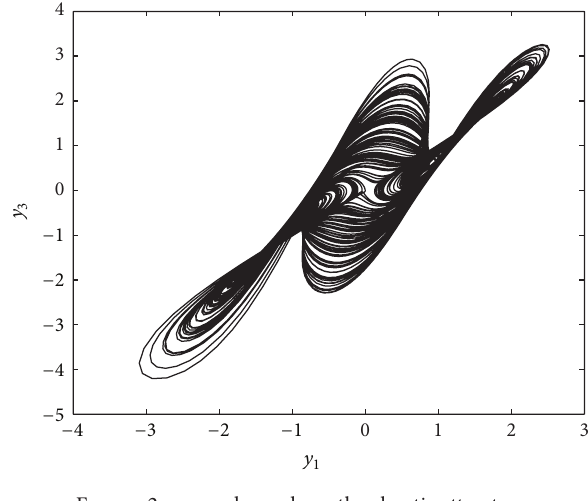
Figure 2: 𝑦 1 - 𝑦 3 phase plane, the chaotic attractor.